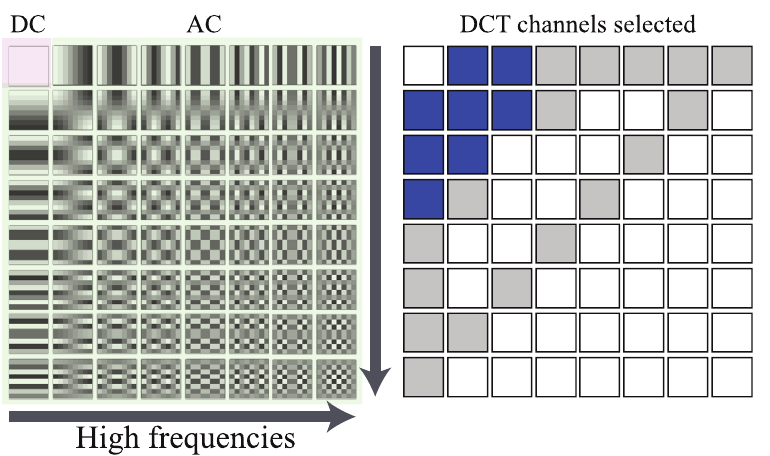
Fig 5. Left: the 64 basis related to the 8 × 8 DCT transformation . The DCT channels that represent the high frequencies are located in the lower right corner. Therefore, they are discarded. Right: Schema used to show the DCT channels selected. Gray background square (including blue ones) represents the DCT channels selected in [36]. Our approach uses only de blue ones.